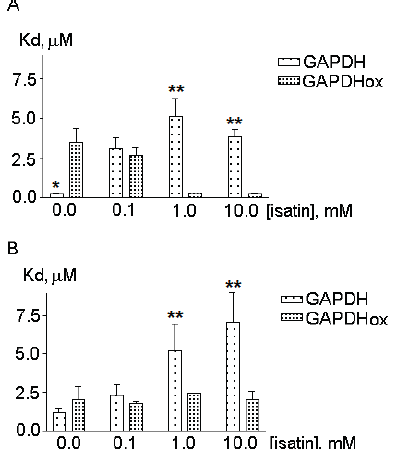
Figure 3. The effect of GAPDH oxidation on K d values for GAPDH interaction with immobilized actin ( A ) and amyloid-beta ( B ). Data represent mean ± SEM from 3–5 independent experiments. Asterisks show statistically significant differences in K d values for intact and oxidized GAPDH ( * p < 0.05; ** p < 0.01) evaluated by paired Student’s t